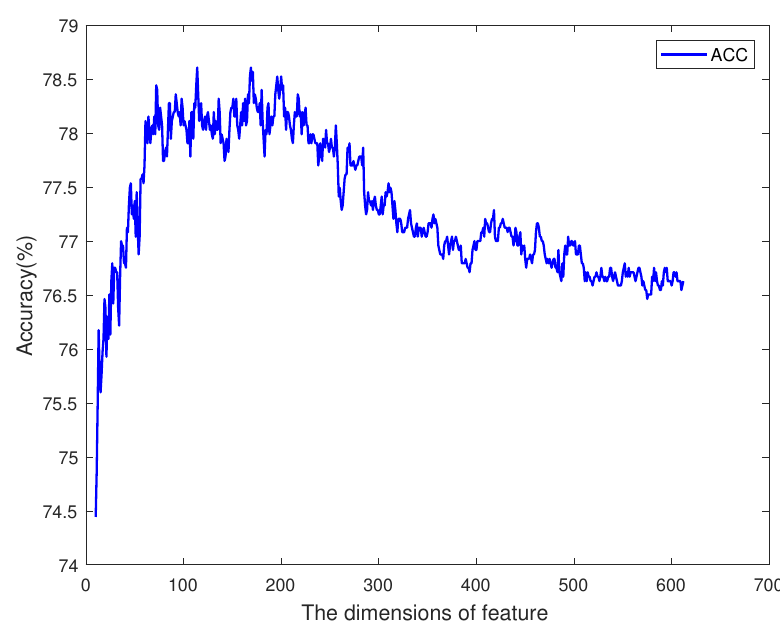
Figure 5. The tendency of accuracy on dimensions of features.